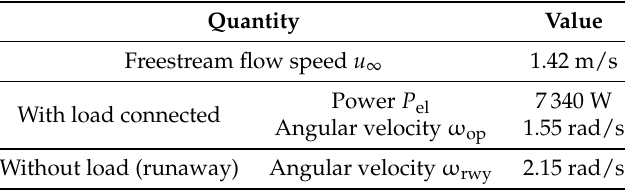
Table 2. Mean results from 30-min measurements.